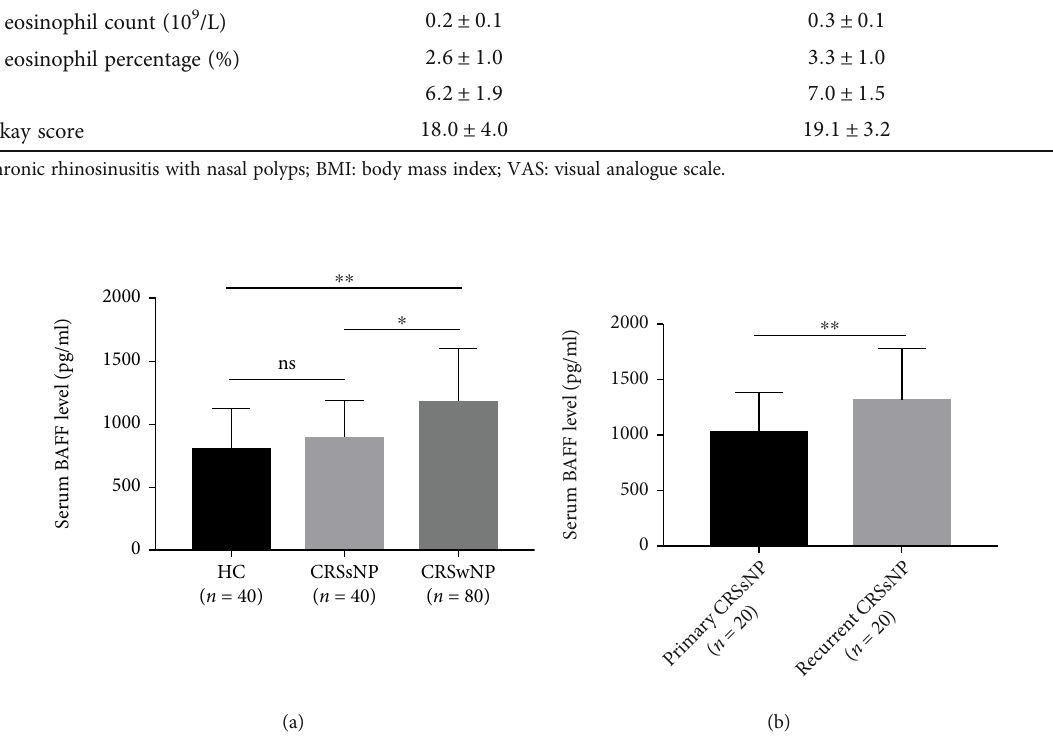
Figure 1: Comparison of serum BAFF levels among three groups. (a) Serum BAFF concentrations were increased in the CRSwNP group than the CRSsNP and HC groups. (b) Serum BAFF concentrations in the recurrent CRSwNP group were higher than the primary CRSwNP group. BAFF: B cell-activating factor; CRSwNP: chronic rhinosinusitis with nasal polyps; CRSsNP: chronic rhinosinusitis without nasal polyps; HC: healthy control; NS: no signi fi cance. ∗ P < 0 : 05 and ∗∗ P < 0 : 01